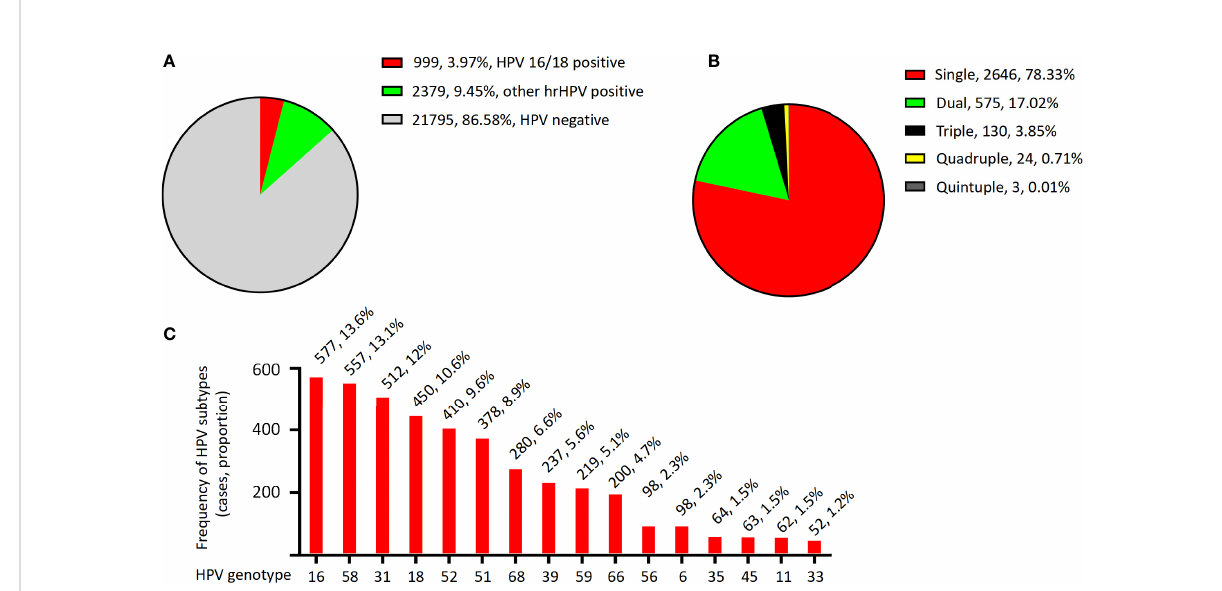
FIGURE 2 The HPV infection distribution. (A) Distribution of HPV genotypes in the women of Nagqu. (B) Distribution of multiple and simple HPV infection in the women of Nagqu. (C) Overall prevalence distribution of each HPV genotype.